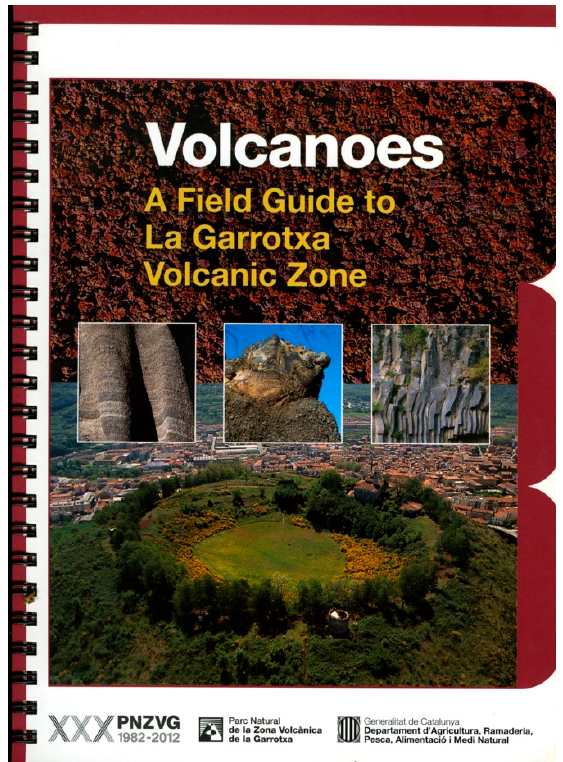
Figure 7. Front cover of the area’s volcanic guide that was designed for users to interpret the zone’s volcanic activity from a single publication. Hence, it has three parts: General description of volcanism, volcanic activity in NE Catalonia, and description of the outcrops of interest to interpret volcanic activity in the area [27].